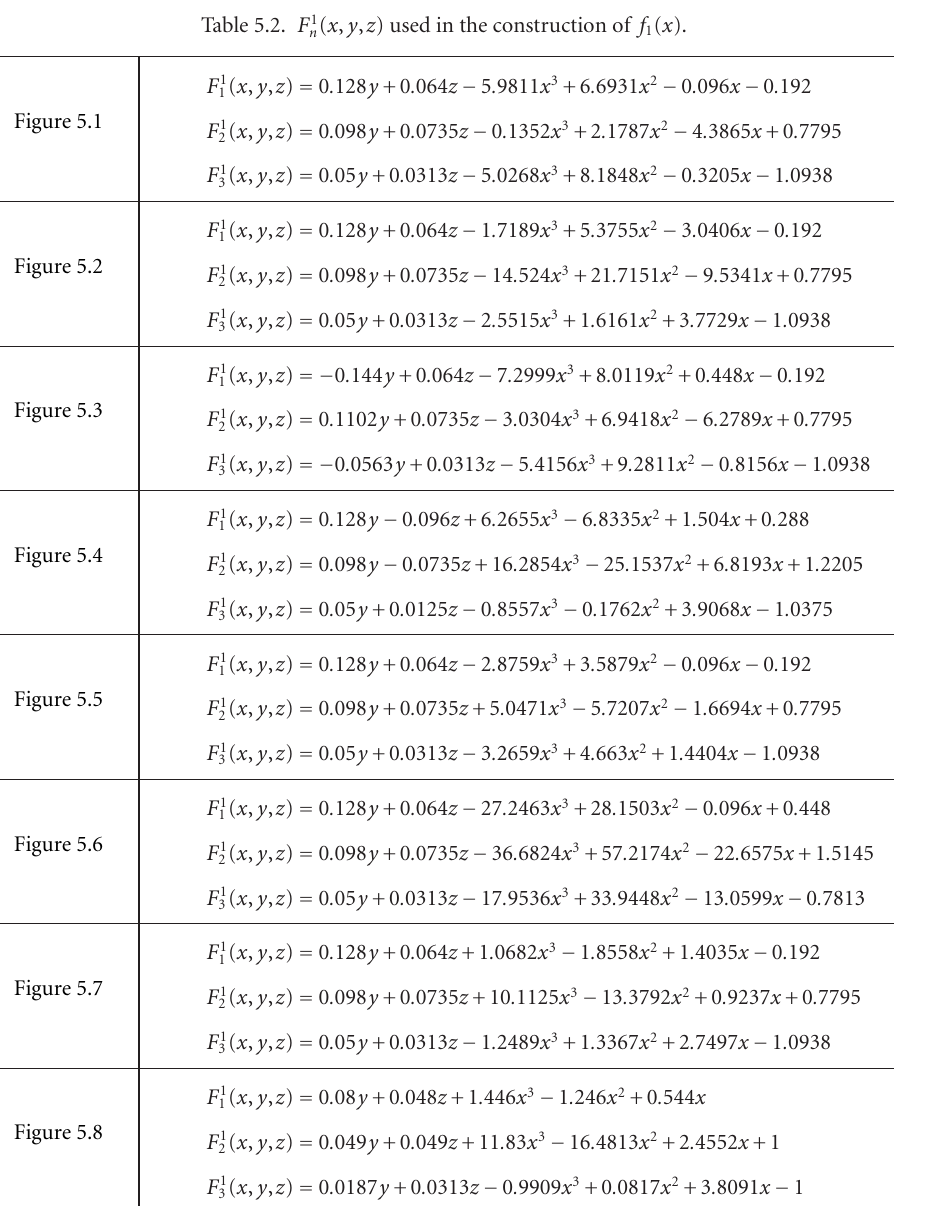
Table 5.2. F 1 ( x , y , z ) used in the construction of f 1 ( x ). n